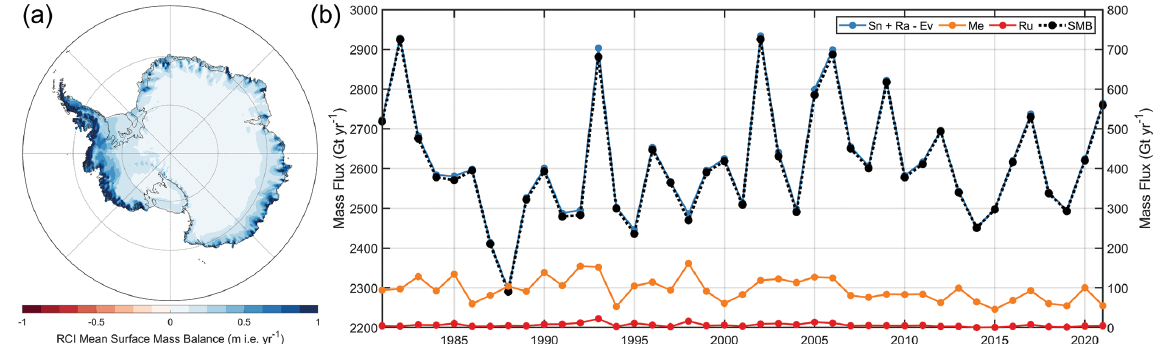
Figure 15. (a) The mean annual surface mass balance of the Antarctic Ice Sheet (AIS; floating and grounded ice) over the reference climate interval (RCI: 1980–2019). (b) Time series of annual SMB and its components (see Eq. 5) for grounded and floating AIS. SMB (black) and net accumulation (blue) use the left axis and runoff (red) and meltwater production (yellow) use the right axis. Note that the two axes span the same range (800Gtyr − 1 ) but are shifted in magnitude. SMB is presented as a dashed line because of overlap with net accumulation. The annual values are calculated from April through March and are defined by the year of the